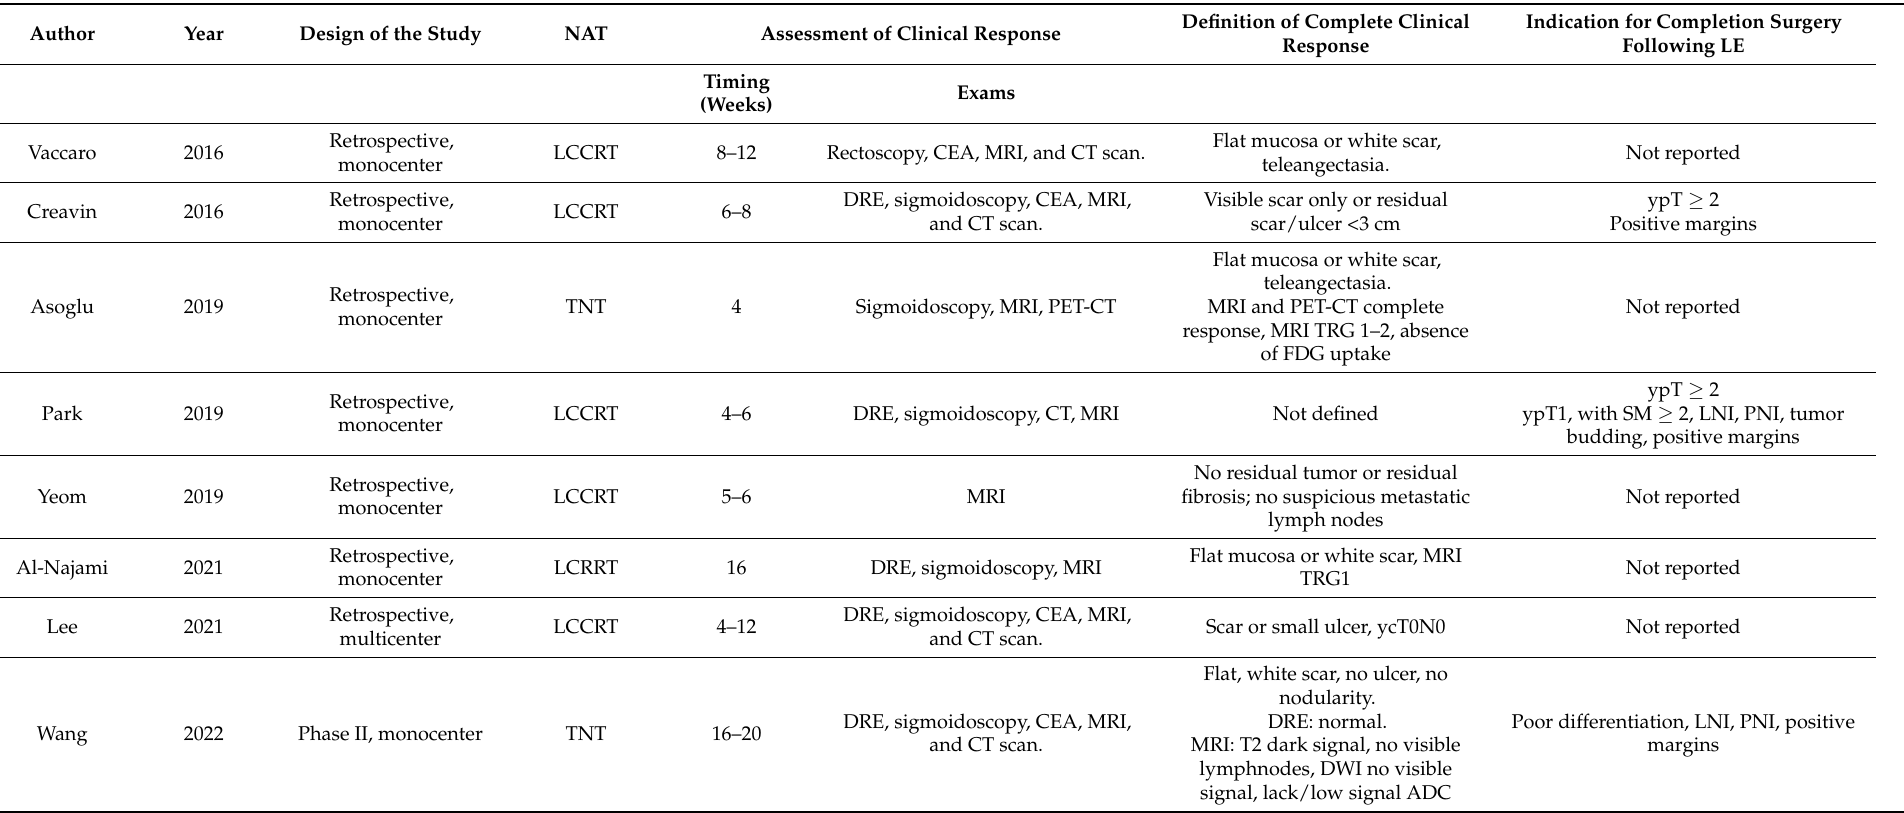
Table 1. Design of the study, type of neoadjuvant treatment, assessment and definition of Complete Clinical Response